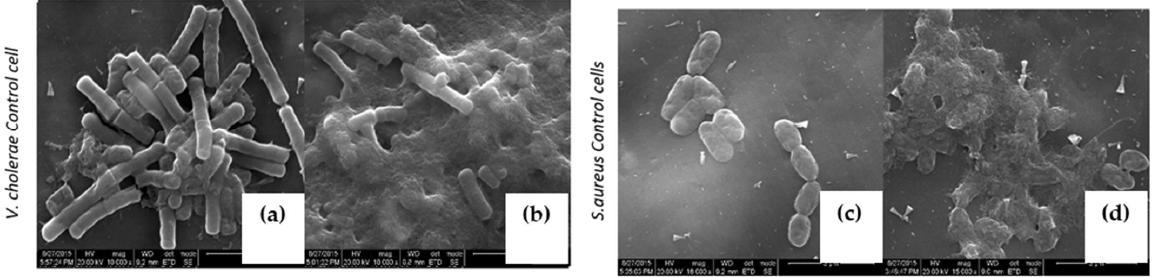
Figure 7. Upon higher level treatment of LBP against V. cholerae and S.aureus. ( a , c ) Untreated V. cholerae and S.aureus cells. ( b , d ) 100 μ g/mL treatment of LBP on V. cholerae and S.aureus respectively.